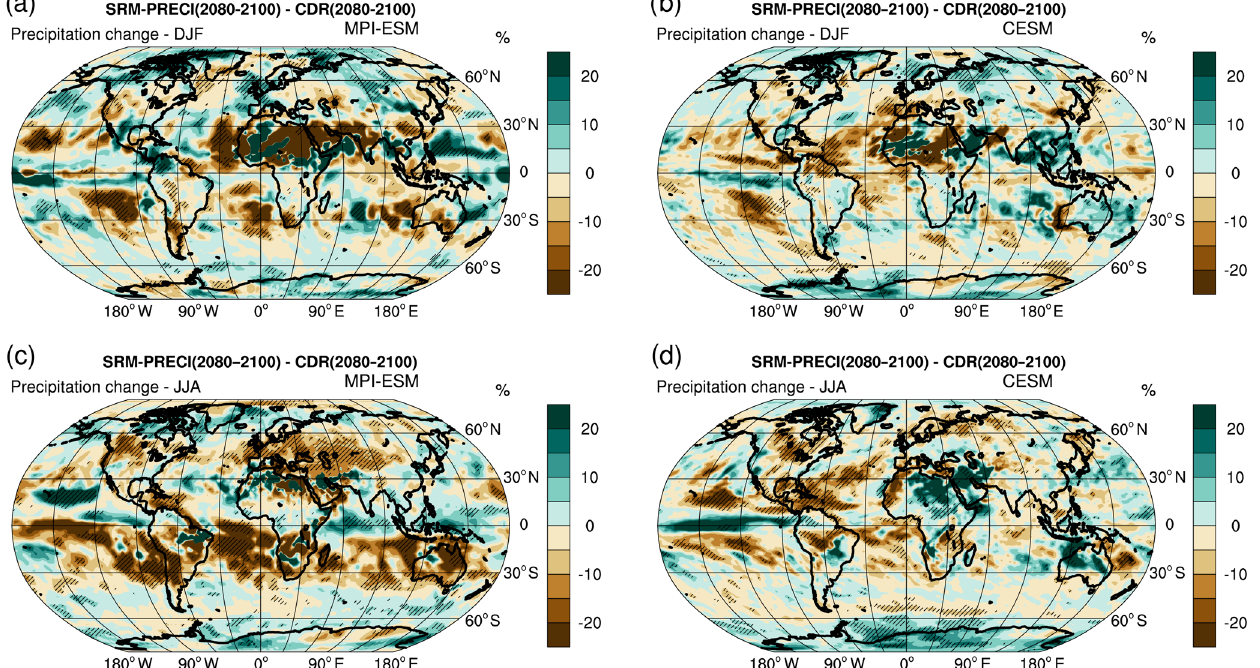
Figure 10. Relative change in precipitation between the SRM-PRECI and CDR scenarios for (a) December–January–February and (c) June– July–August in MPI-ESM, along with the corresponding figures for CESM (b, d) . Hatching indicates regions where the temperature change is statistically significant at the 95% level, with significance levels estimated using a Student’s paired t test with (sample of 20 yearly mean values for three ensemble